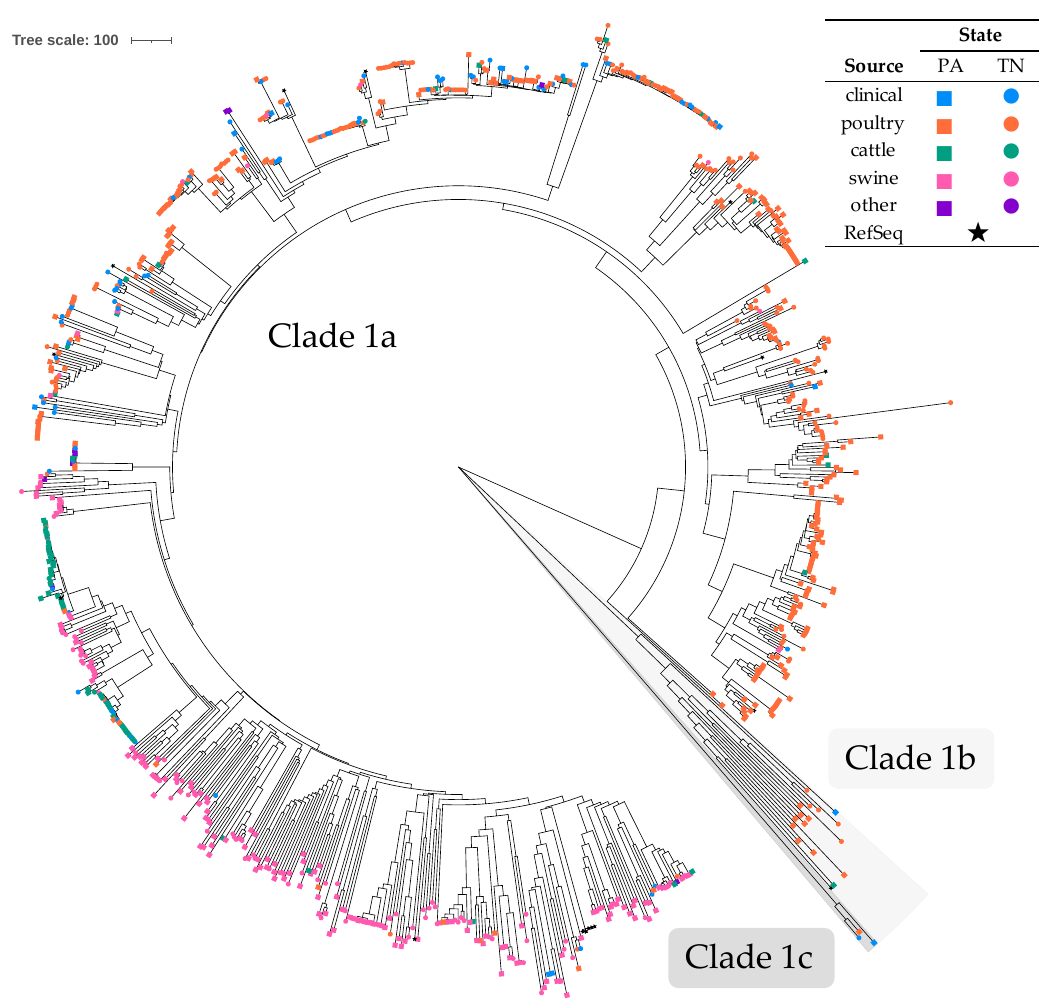
Figure 2. Neighbor-joining phylogenetic tree of C. coli isolates. The optimal tree with the sum of branch length equal to 73,485.2 is shown. The tree is drawn to scale, with branch lengths representing core SNP distances. There were a total of 11,628 core SNP positions in the final dataset. Symbols at the end of tree leaves indicate isolation location and source (see legend). Figure S2 is an alternate rendering of the tree with bootstrap values and additional